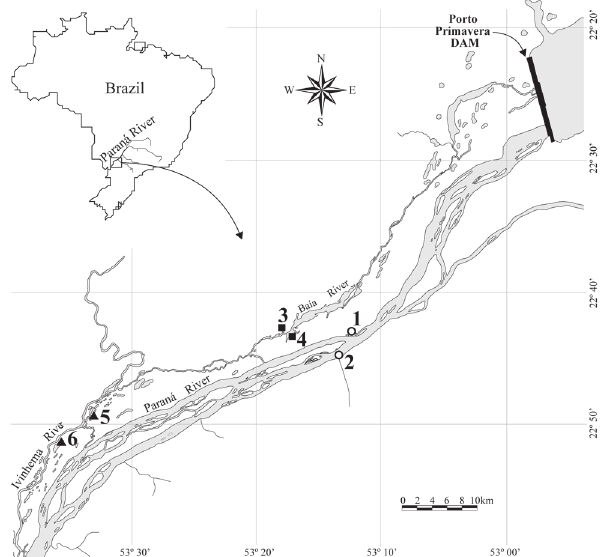
Fig. 2. Monthly ( a ) and daily level ( b , between January and March) of the upper Paraná River recorded in Porto São José municipality. In b (right axis), the number of days between January and March, when the upper Paraná River surpassed the threshold of 350 cm (horizontal braked line). The years 2000 and 2001 were considered as years of short floods and 2002 and 2003 as years of moderate floods. Source: National Department of Waters and Electric